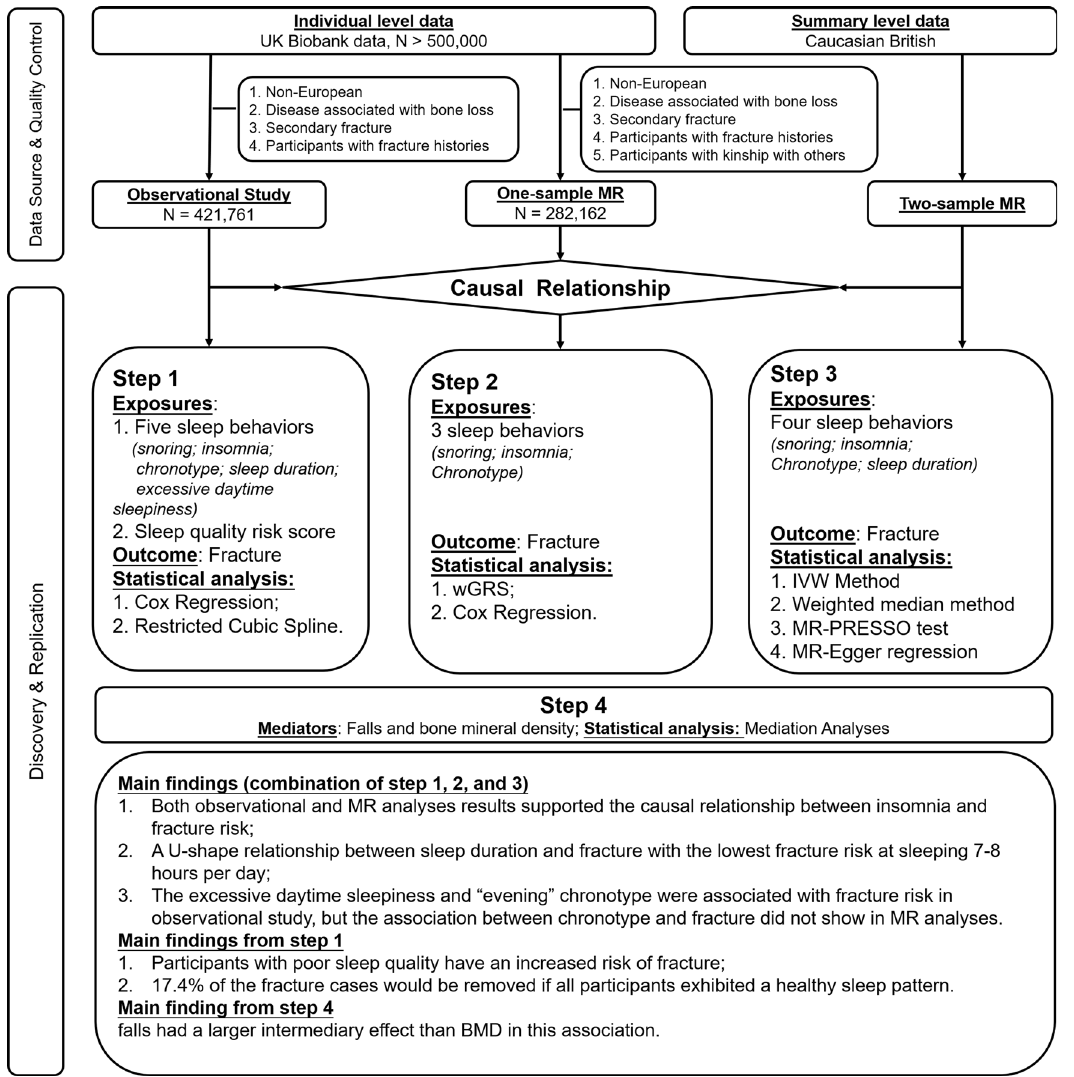
Fig. 4 An overview of the study design. IVW inverse-variance weighted, MR Mendelian randomization, MR-PRESSO MR pleiotropy residual sum and outlier, wGRS weighted genetic risk